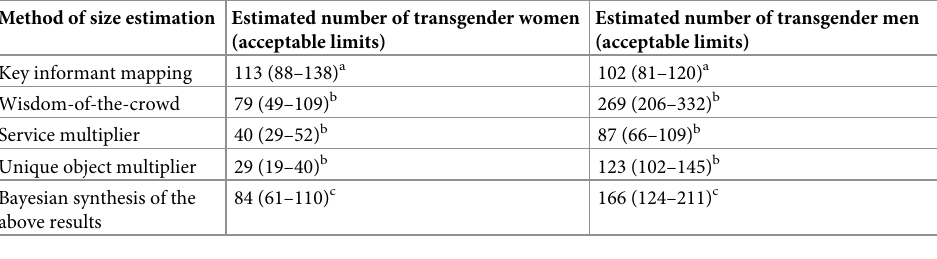
Table 2. Population size estimates of transgender women and transgender men in Bhutan,